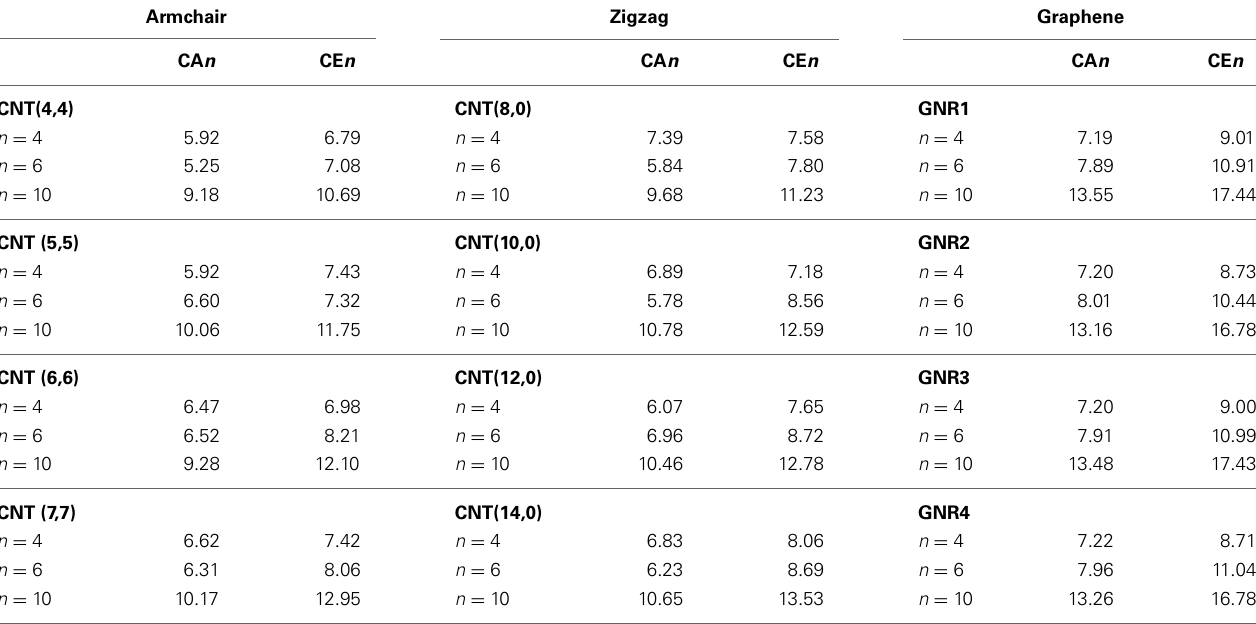
Table 3 | BE (kcal/mol) of CNSs with various cyclic saturated (CA n ) and unsaturated (CE n ) hydrocarbons at M06-2X/6-311G ** //ONIOM (M06-2X/6-31G * : AM1)